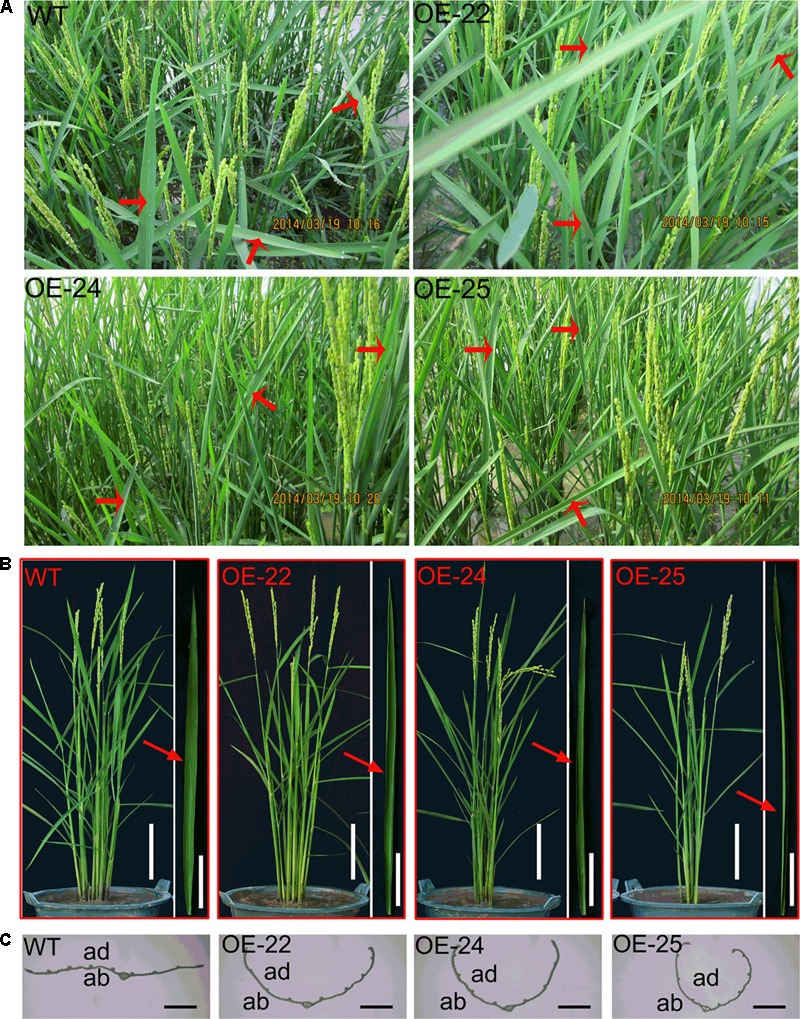
The leaf phenotype of the WT and OE-OsRKK1 plants. (A) Morphology of WT plants and the OE-OsRRK1 plants at the heading stage in the paddy field. Red arrow indicated the leaf morphology. Leaves of WT plants were flat, whereas the flag leaves of OE-OsRRK1 plants were rolled to different degrees in the field. (B) Mature leaves of the WT and OE-OsRRK1 plants at the heading stage in a bucket (Bar = 10 cm). The corresponding close-up images of the flag leaf architecture details are shown besides each bucket image (Bar = 5 cm). (C) Cross-section of the middle part of the flag leaf in the WT and the OE-OsRRK1 plants at the heading stage. ad, adaxial; ab, abaxial. Bars = 2 mm.